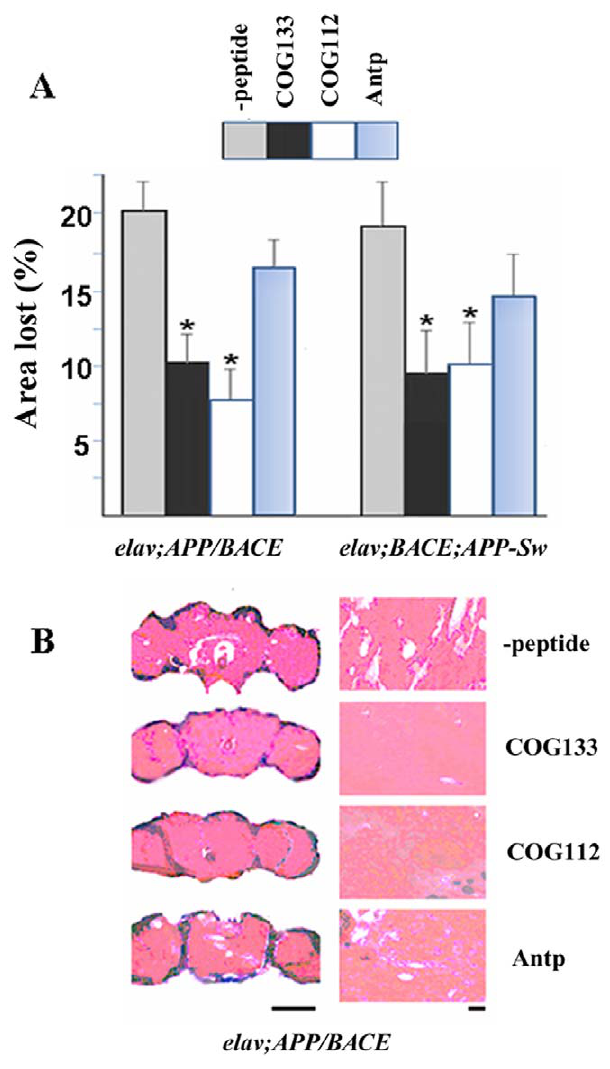
Figure 5. ApoE-mimetics inhibit neurodegeneration in Dro- sophila brain. A ) Effect of peptides on percentage of the area lost in the regions of the cell body and neuropil: The ratio of lost area was calculated by dividing the sum of the vacuole areas from all brain sections by the total area of the brain from all brain sections. Percentage of the area lost is shown as averages 6 SEM. p , 0.05 Asterisks indicate significant differences from control. B ) Effect of peptides on neurodegeneration in APP transgenic flies. Paraffin slices were stained with hematoxylin and eosin and were examined under bright-field illumination using a Leica DM 2500 microscope at a magnification of 120X. Left panel- Bar, 50 m m; Right panels - Bar, 10 m m.